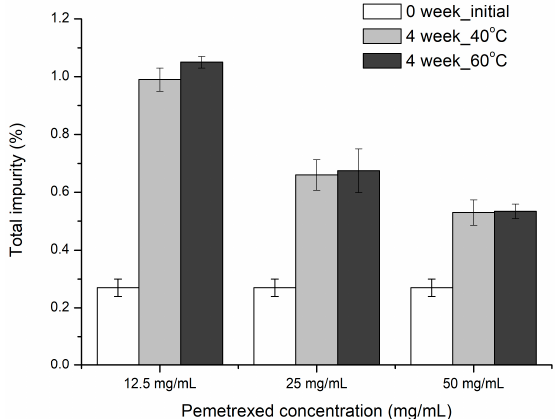
Figure 5. Effect of pemetrexed concentration on its degradation in aqueous solution induced by stress condition at 40 and 60 °C for four weeks.